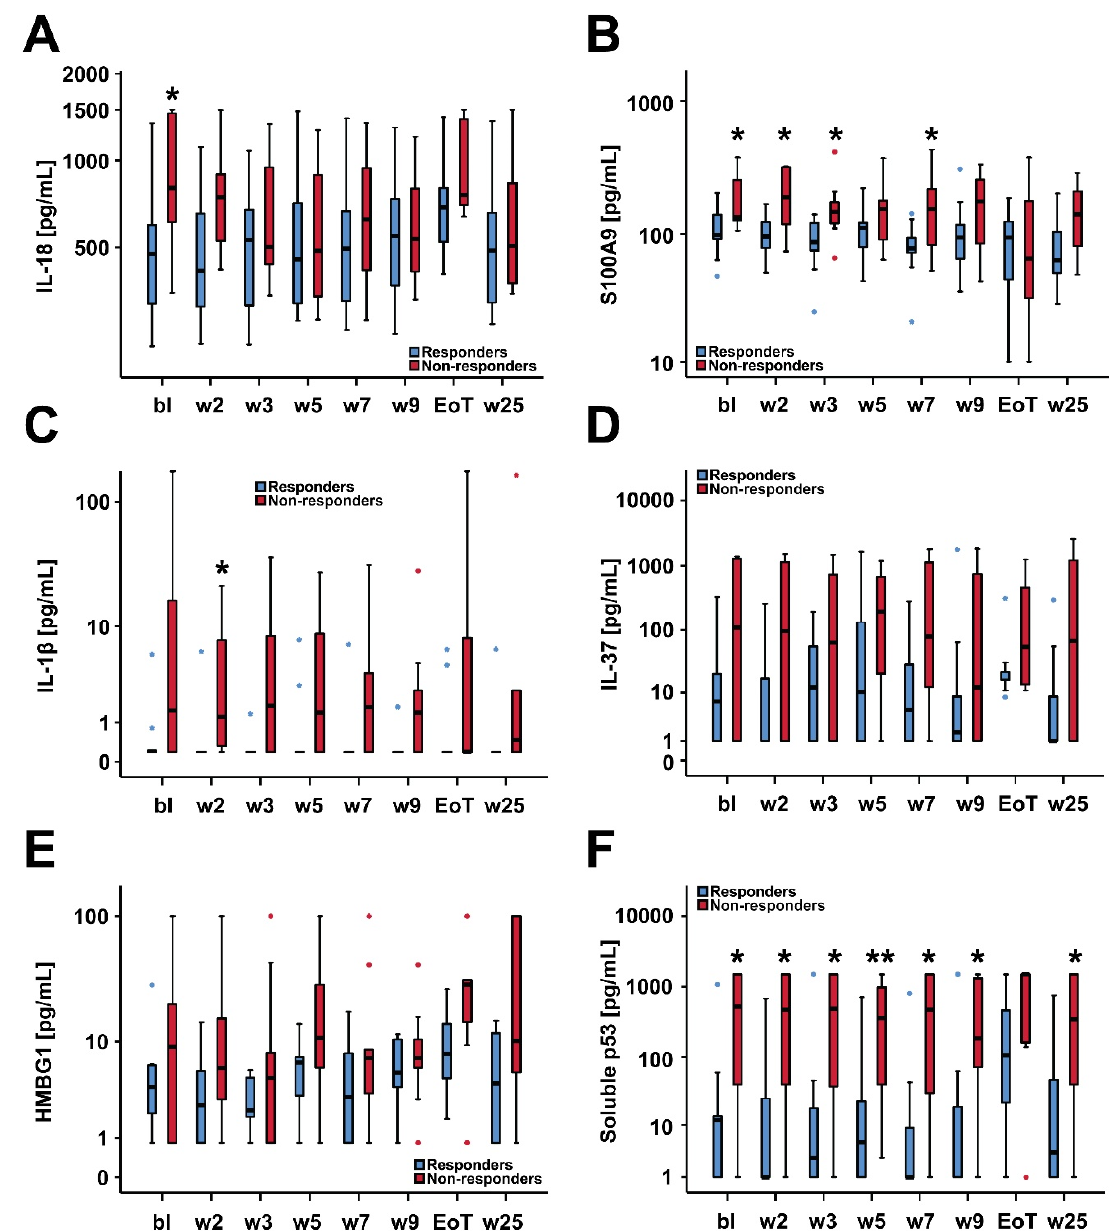
Figure 2. Box plot diagrams of serum levels of IL-18 ( A ), S100A9 ( B ), IL-1 β ( C ), IL-37 ( D ), HMGB1 ( E ) and soluble p53 ( F ) in responding (n = 9) versus non-responding (n = 10) patients at defined study visits. Median serum biomarker levels were compared in responding versus non-responding patients applying the Mann–Whitney test (* p < 0.05, ** p < 0.01). Abbreviations: bl, baseline; w, week; EoT, end of treatment (i.e., week 13 visit).